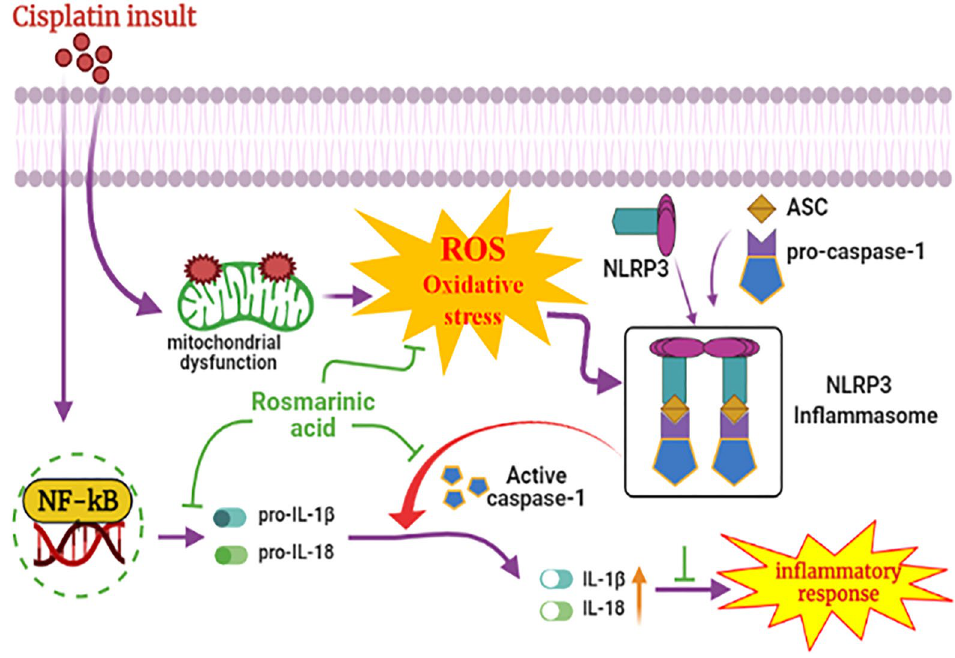
Figure 8. Summarized schematic pathway representation of NLRP3 inflammasome modulation by RA administration in CP-induced mouse AKI model. RA showed anti-inflammatory effects by inhibiting the proinflammatory markers in the mouse